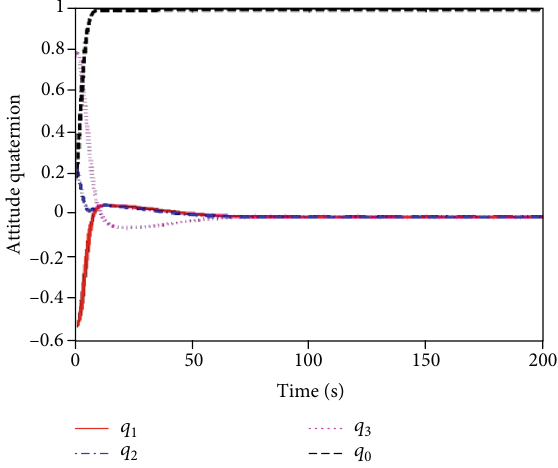
Figure 3: Time histories of attitude quaternions in Case 1.